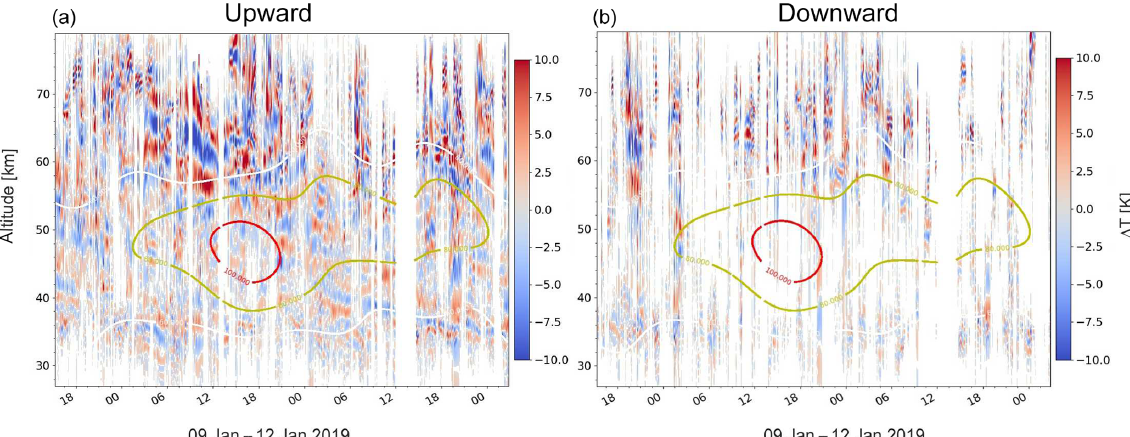
Figure 10. Reconstructed temperature fluctuations of upward-propagating GWs (a) and downward-propagating GWs (b) . Contour lines show the background zonal wind, and the numbers on the contour lines are given in meters per